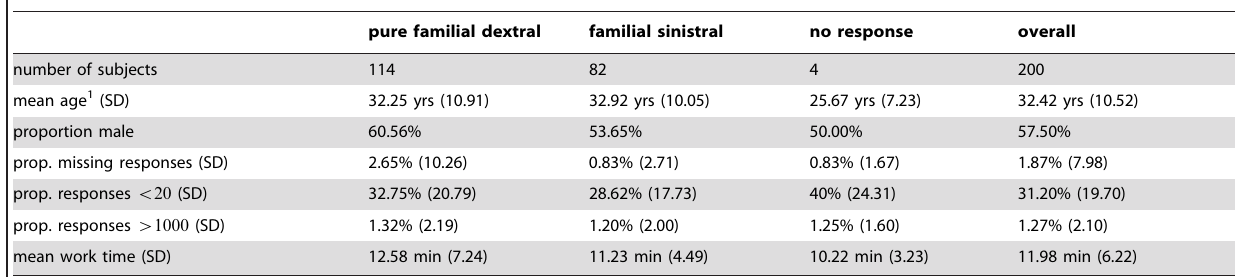
Table 2. Overview of